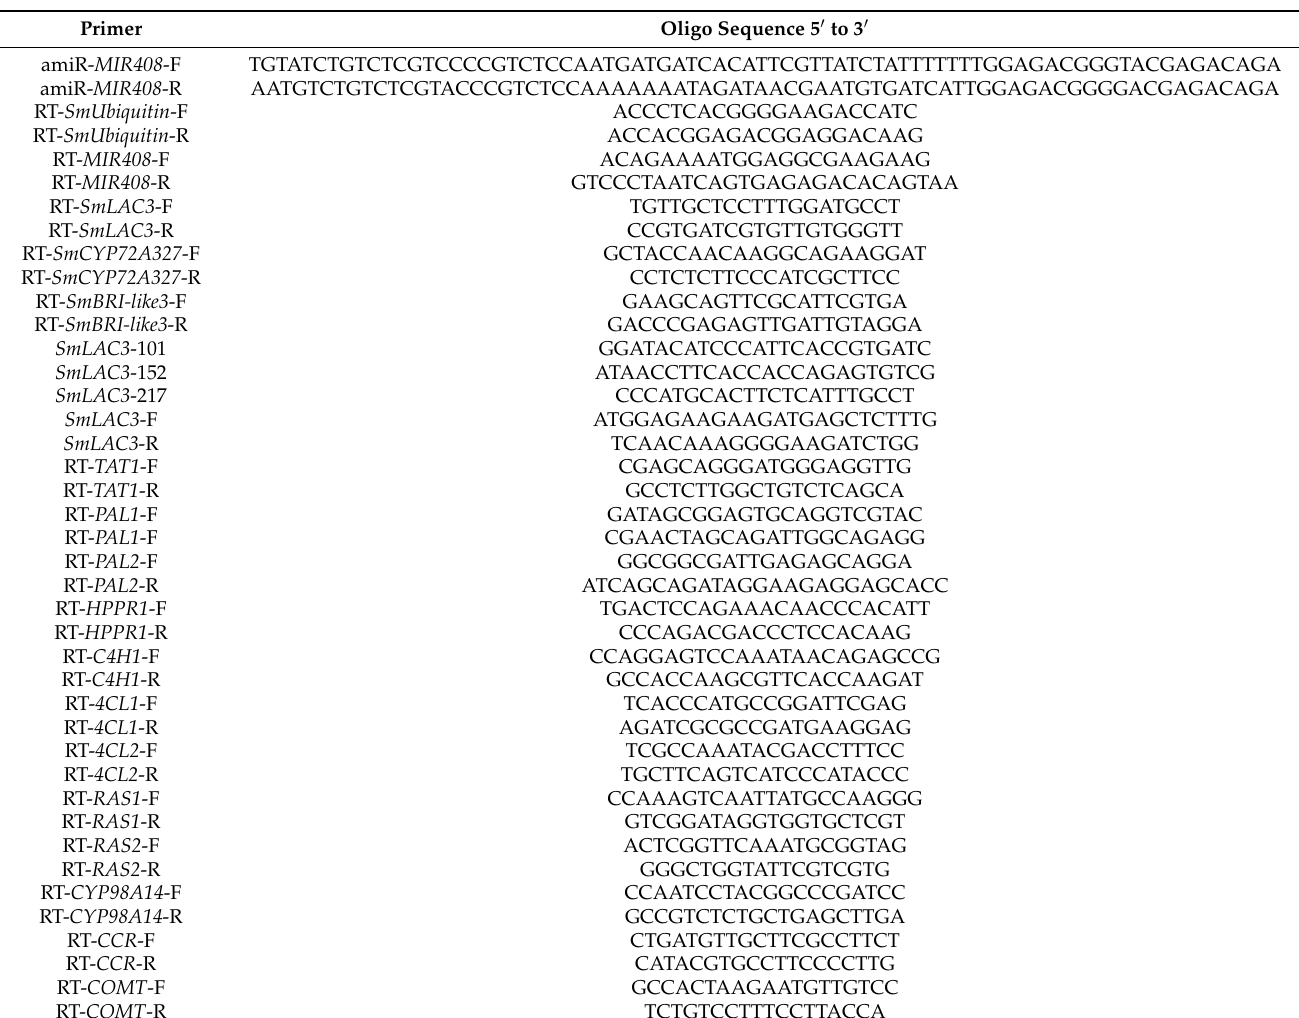
Table 2. List of primers used for